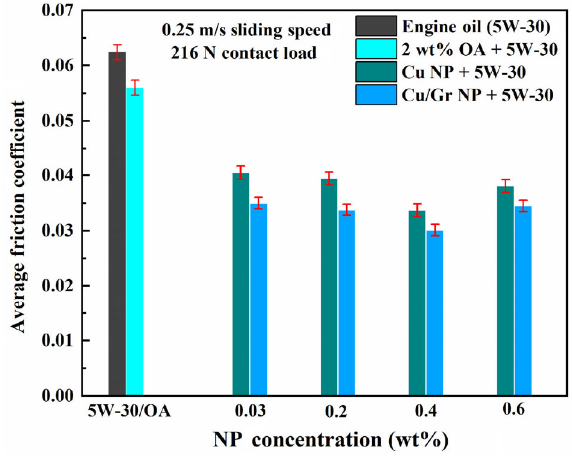
Fig. 4 Effect of the Cu and Cu/Gr nano-additives concentration on the COF. The error bars indicate the standard